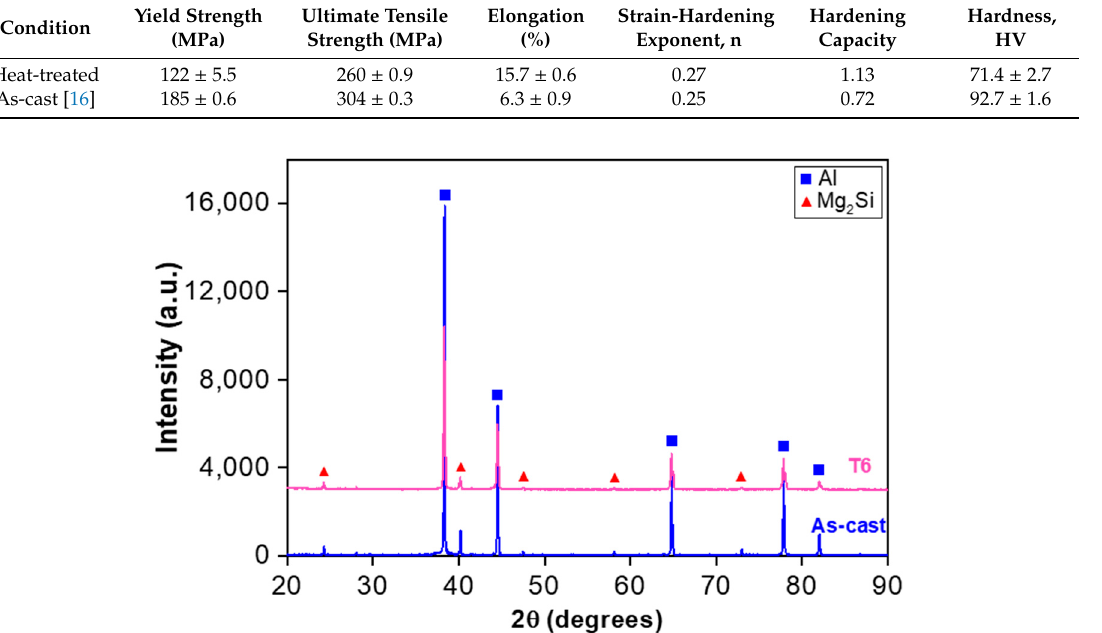
Figure 4. XRD patterns of the heat-treated and as-cast alloys. Table 1. Comparison of the tensile properties of the AlMgSiMnFe alloy in the heat-treated and as-cast conditions (strain rate: 1 × 10 − 2 s − 1 ).